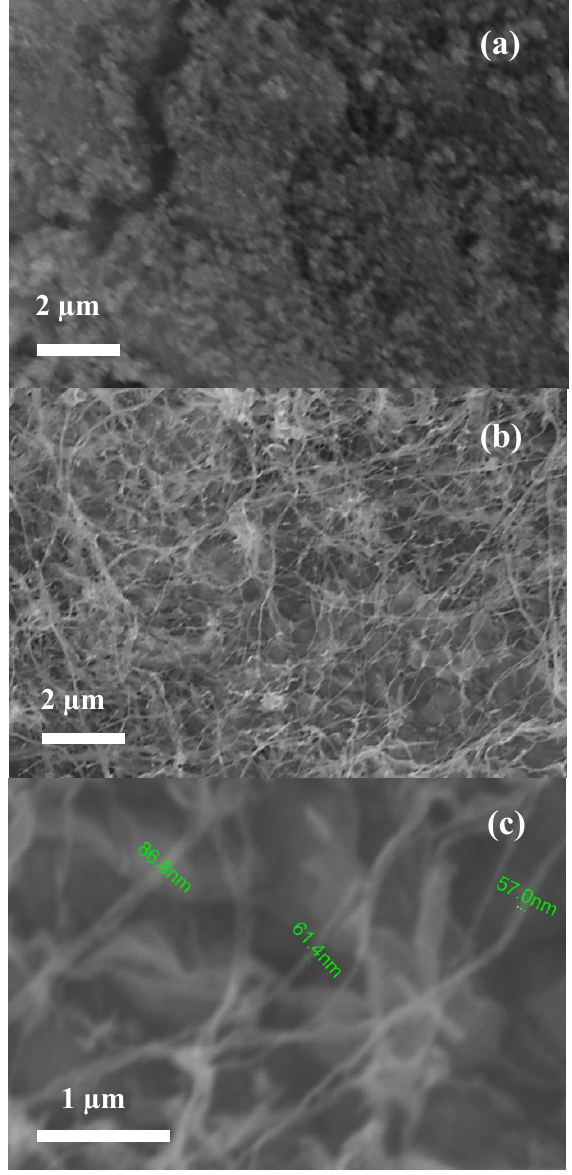
Figure 3. SEM images showing the morphology of samples annealed at 400 °C and deposited on the sensor substrate. ( a ) ZnO NPs; ( b ) ZnO NFs; ( c ) Higher magnification of ZnO